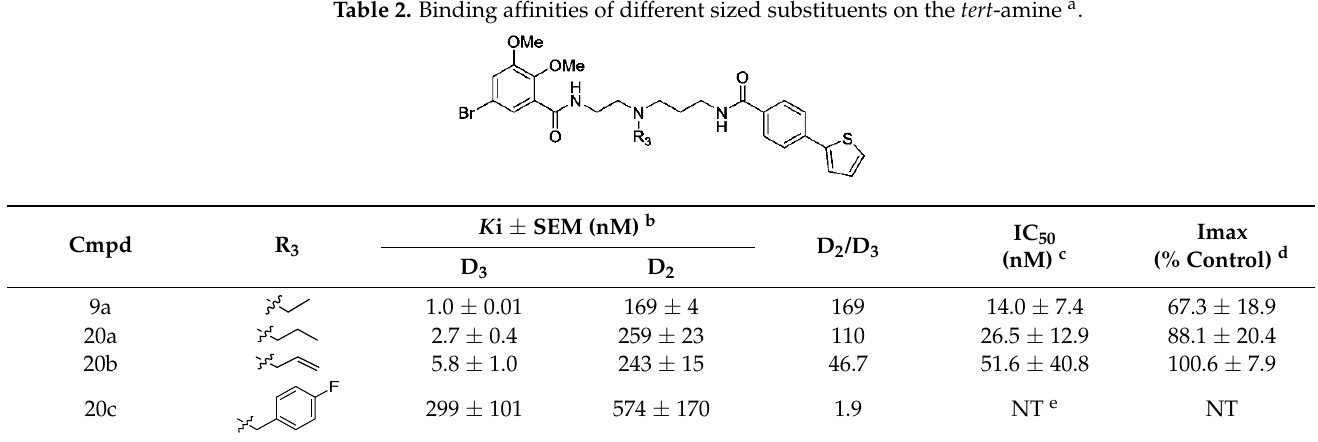
Table 3. R 3 optimization based on carboxamide moieties a . Cmpd